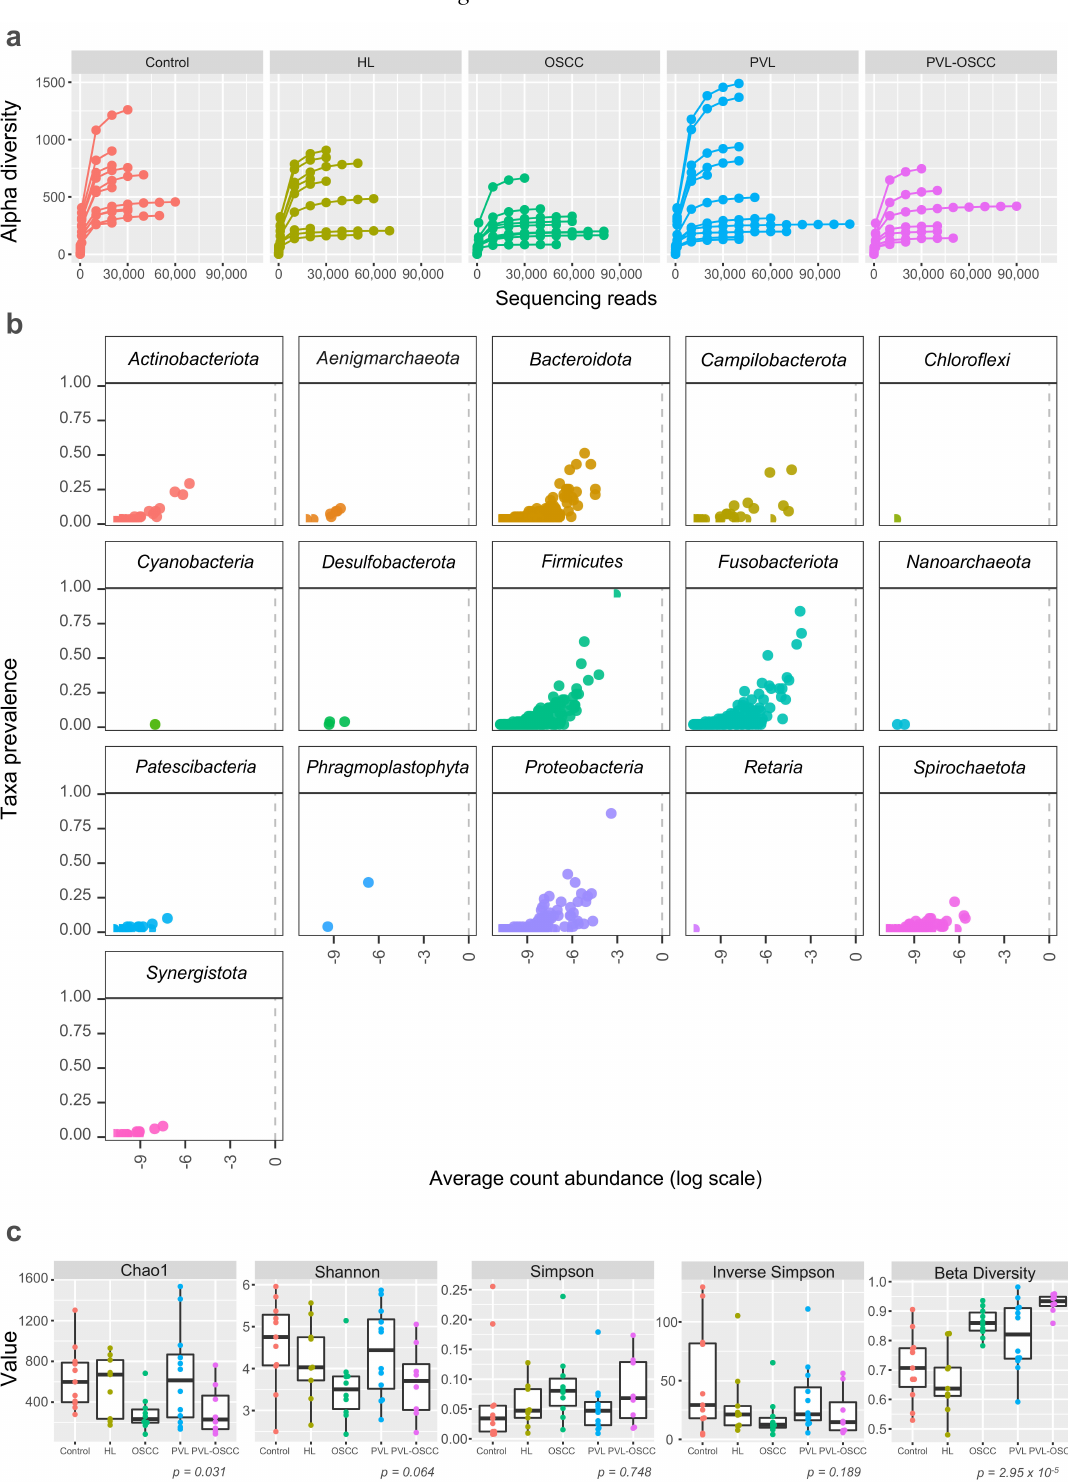
Figure 1. Microbiome diversity for oral samples collected from healthy controls and HL, PVL, OSCC, and PVL-OSCC patients. ( a ) Rarefaction curves (alpha diversity versus sequencing library size). ( b ) Prevalence plot (taxa prevalence versus average count abundance). Each point corresponds to a different amplicon sequence variant. ( c ) Microbial richness (Chao1), diversity (Shannon), dominance (Simpson and Inverse Simpson), and similarity (beta divergence) of oral